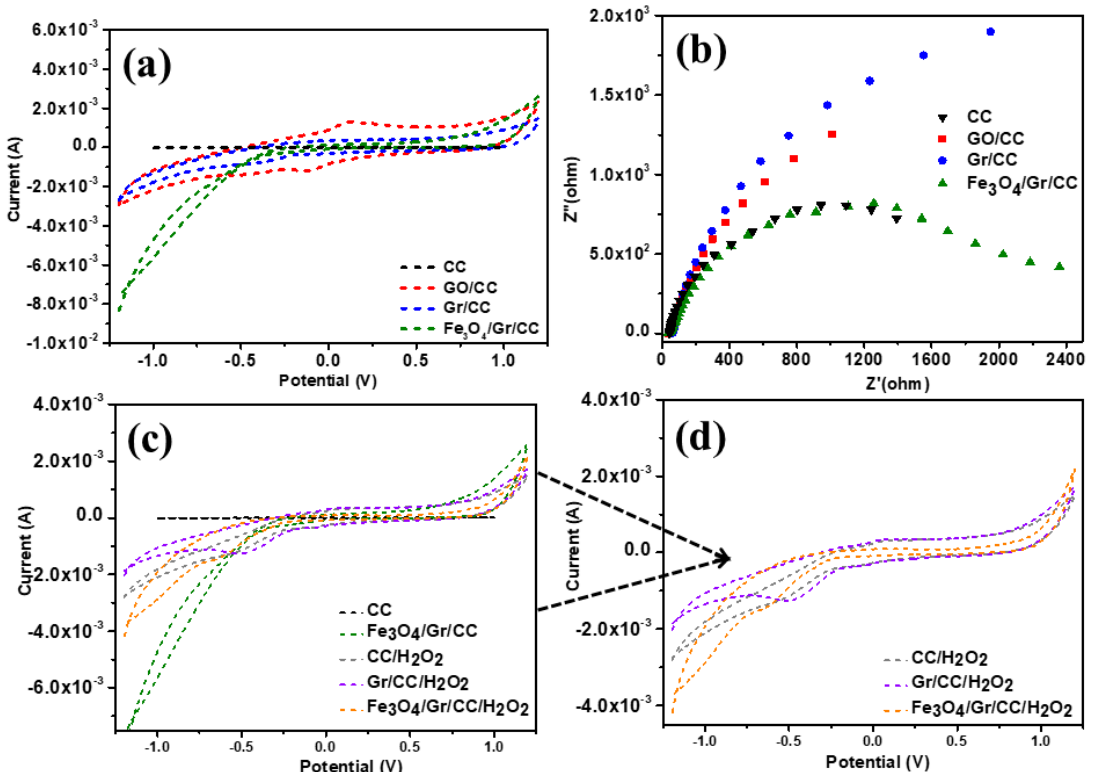
Figure 5. Electrochemical test of fabricated electrodes, ( a ) CV and ( b ) EIS of CC, GO/CC, Gr/CC, and Fe 3 O 4 /Gr/CC in 0.1 M PBS (pH = 7.0), ( c ) comparative CVs of CC, Gr/CC, and Fe 3 O 4 /Gr/CC in 0.1 M PBS (pH = 7.0) with and without H 2 O 2 at a scan rate of 0.08 V s − 1 ( d ) CVs of CC, Gr/CC, Fe 3 O 4 /Gr/CC with H 2 O 2 in 0.1M PBS, pH=7.0 (CC/ H 2 O 2 , Gr/CC/ H 2 O 2 , Fe 3 O 4 /Gr/CC/ H 2 O 2 ).